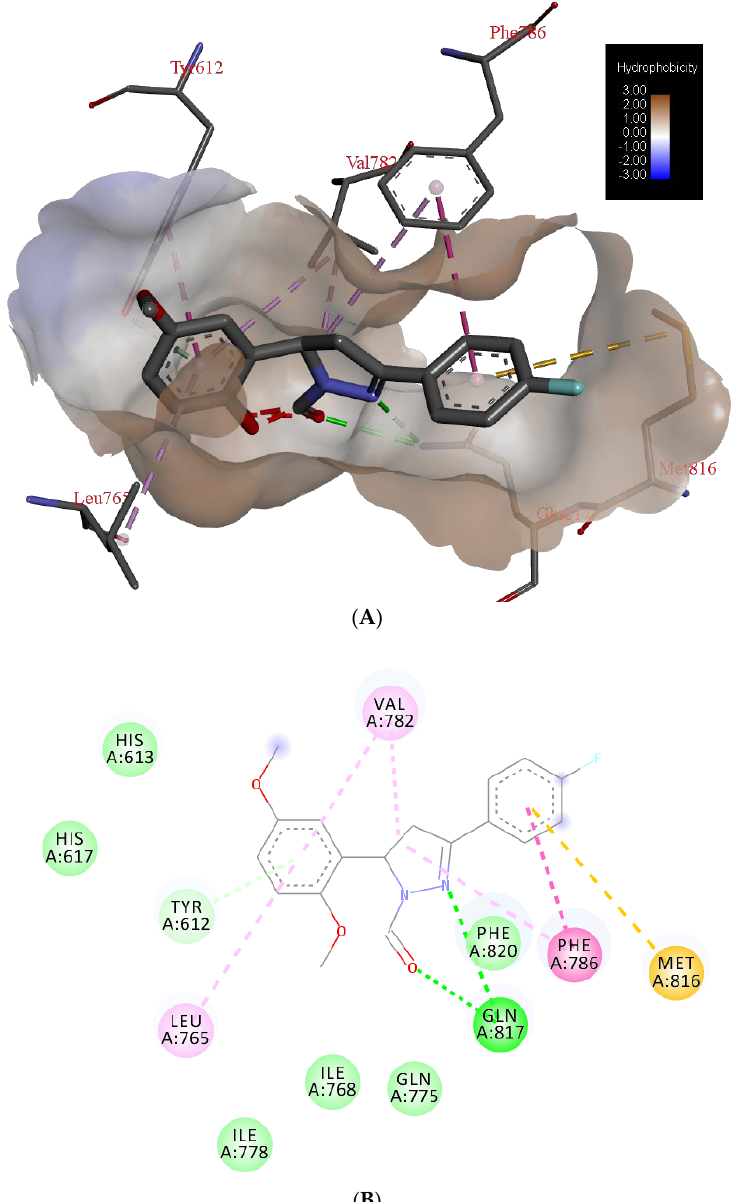
Figure 4. The main interactions of compound 3g with residues in catalytic domain of PDE5: ( A ) 3D representation and hydrophobic surface of the binding site, ( B ) 2D representation (green = conventional hydrogen bond, light green = van der Waals, very light green = π -donor hydrogen bond, purple = π - σ interactions, light purple = π - π interactions, pink = alkyl and π -alkyl interactions, brown = π -sulphur bond).